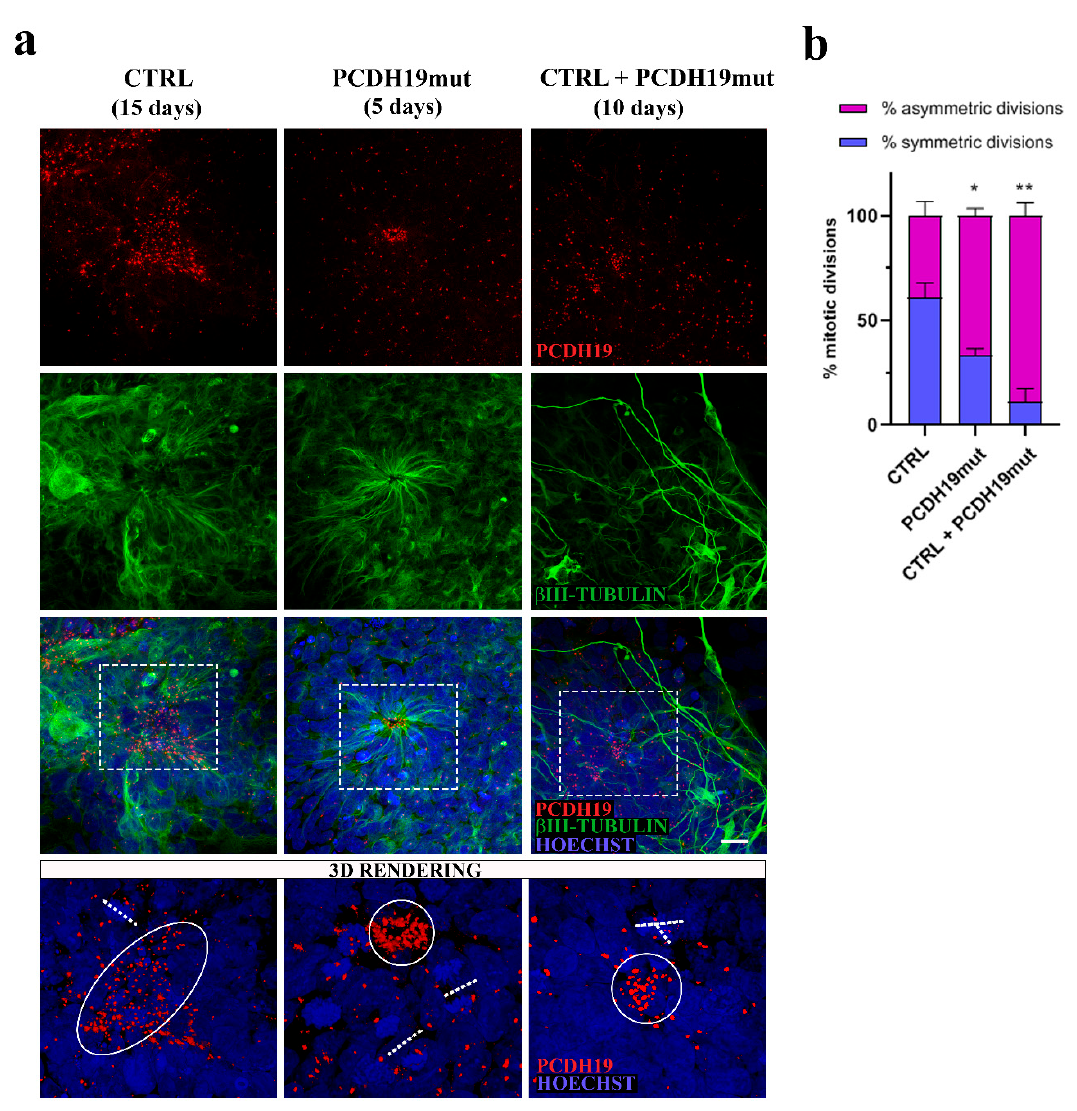
Figure 5. Analyses of dividing cells at the stage of neural rosettes. ( a ) Maximum intensity projections (MIP) of confocal micrographs of immunofluorescence assays for PCDH19 and β III-tubulin showing the structure of neural rosettes derived from CTRL, PCDH19mut and mixed iPSCs. Scale bar = 20 µ m. 3D rendering shows the type of division close to the center of the rosettes; ( b ) Quantification of symmetric and asymmetric cells in mitosis. Data are normalized to control and presented as mean ± SEM. Statistically significant difference is calculated with ordinary one-way ANOVA parametric test (* p < 0.05) (** p < 0,01), n =